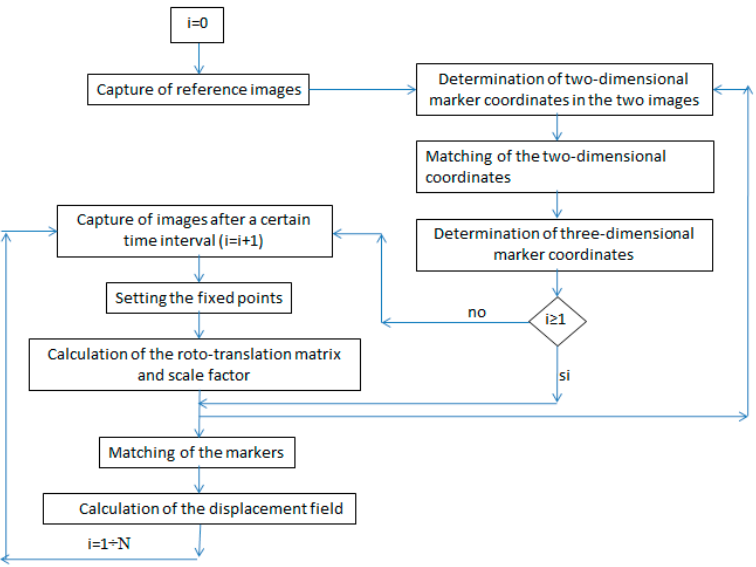
Figure 2. Flow ‐ chart of the schematic representation of the algorithm. Table 1. Comparison between the characteristics of the marker tracking (MT) (2D, 3D) and digital image correlation (DIC) (2D, 3D) techniques.